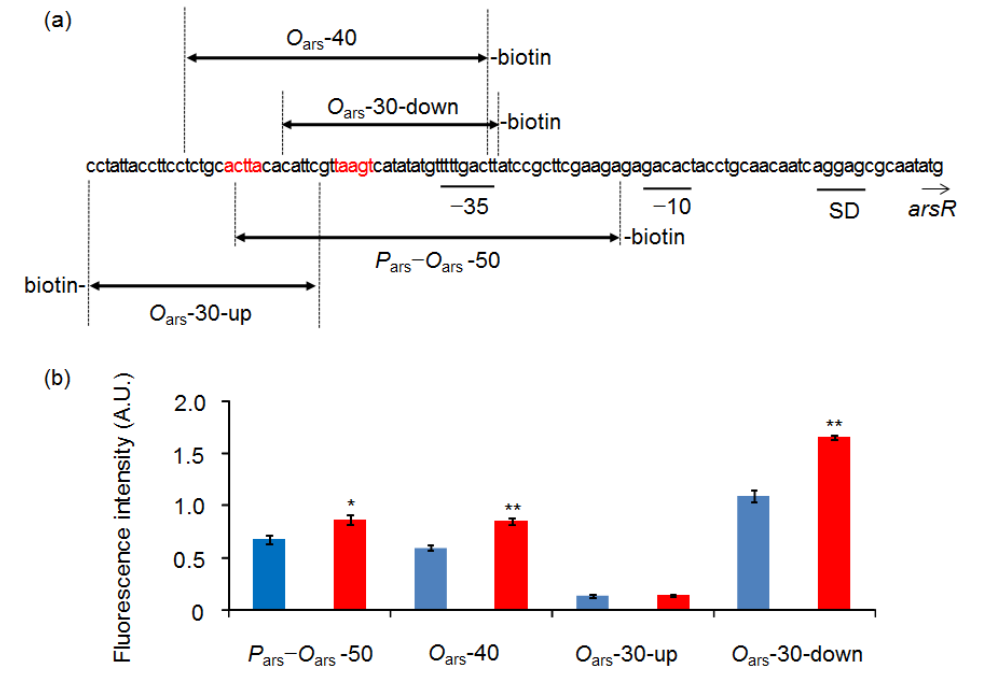
Figure 3. Nucleotide sequences of the oligonucleotides containing O of their sequence difference on the biosensor response to As(III) ( b ). The ArsR binding sites are shown in red (a). The putative promoter sequences at the − 35 and − 10 recognition sites and the Shine-Dalgarno sequence (SD) are underlined. The oligonucleotide ends, to which biotin was bound, was shown. Fluorescence was measured with fluororeader (b). Average fluorescence intensities are shown with blue bars for no addition of As(III) and red bars for 100 μ g/L As(III) in purified water. Statistical significance was shown as * p < 0.01; ** p <